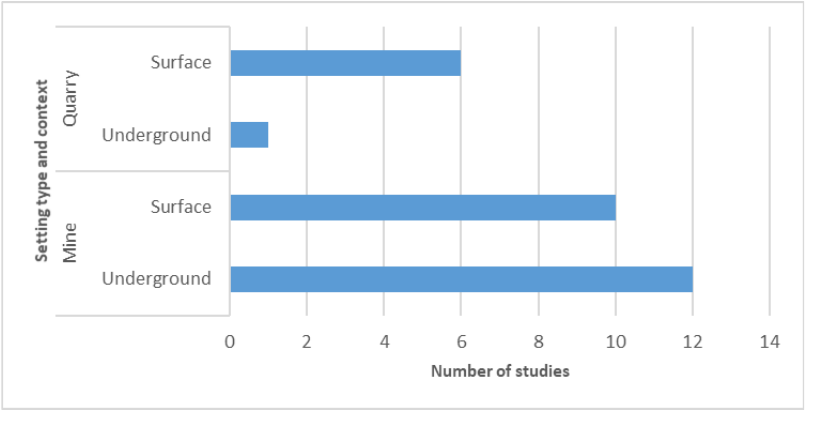
Figure 3. Study distribution per setting and country.